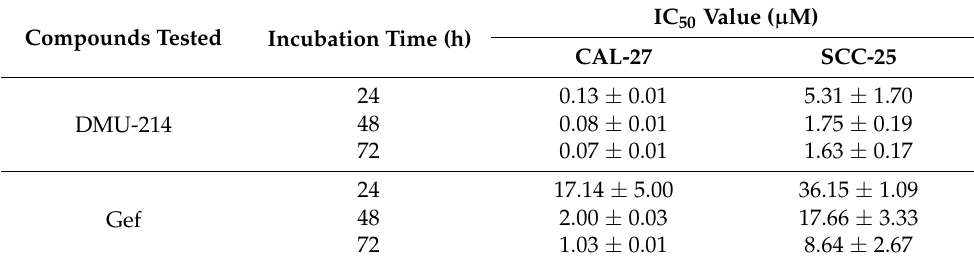
Table 1. IC 50 values for DMU-214 and Gef in CAL-27 and SCC-25 cell